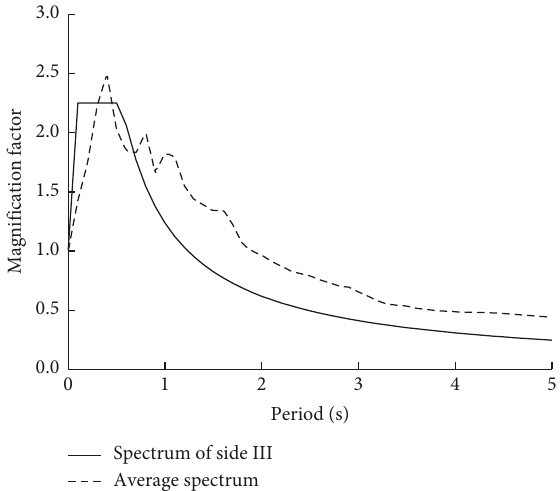
Figure 6: Average spectrum and code spectrum of site